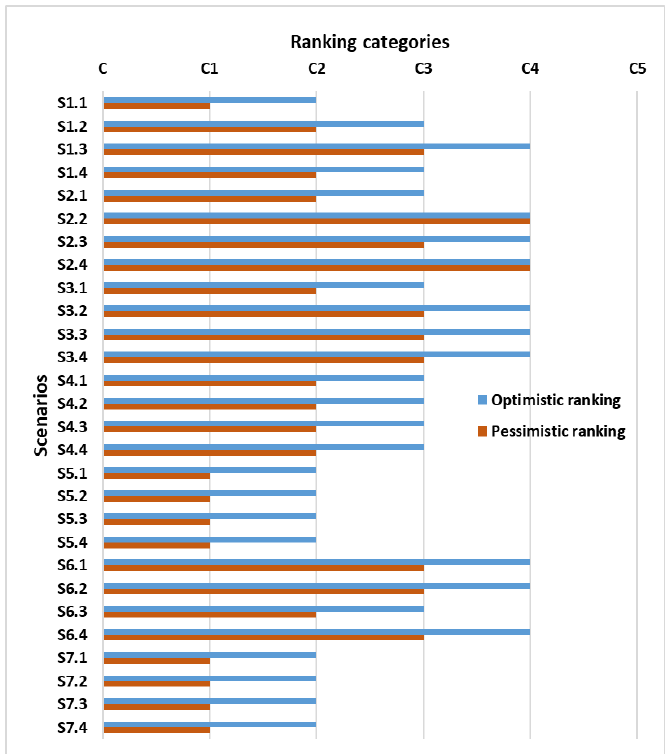
Figure 13. Ranking of the scenarios with λ = 0.70.